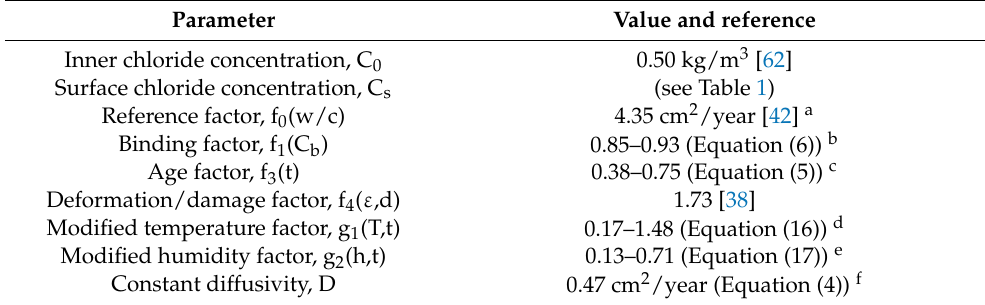
Table 3. Used parameters and their